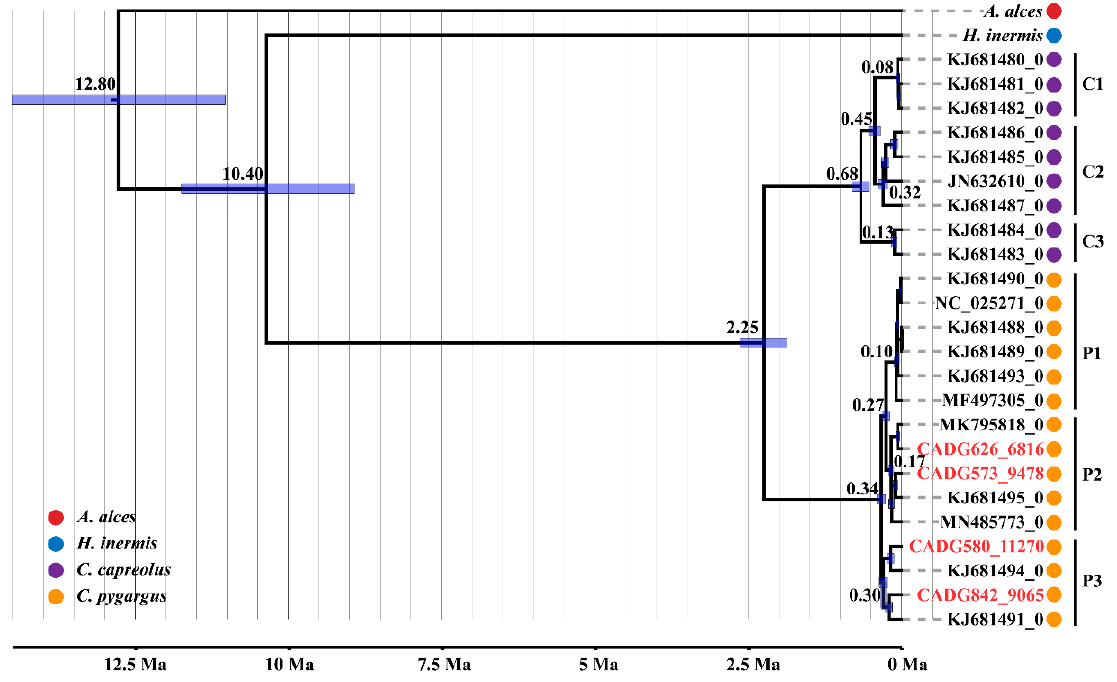
Figure 2. Maximum clade credibility tree of Capreolus computed in BEAST based on complete mitogenomes. Node heights are centered on the median posterior age estimates ( X -axis; Ma) and blue node bars show 95% credibility intervals of the divergence times. Tip dates of specimens are indicated following the accession/sample number. The four ancient samples from this study are labelled in red letters.